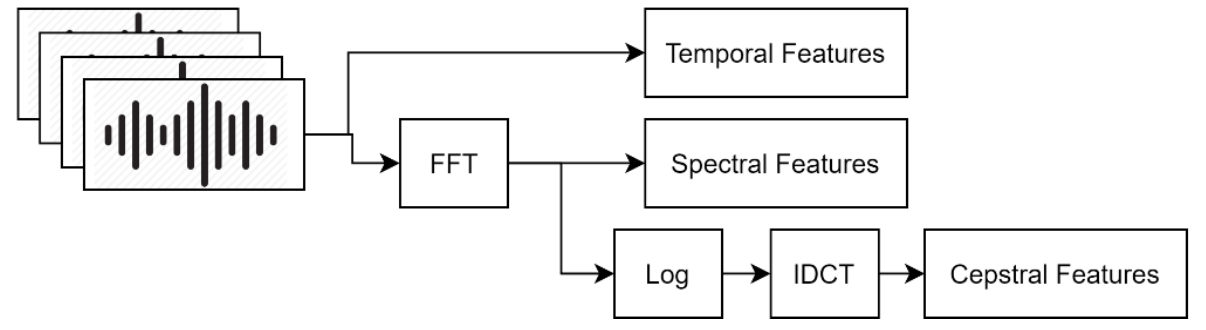
Figure 1. Taxonomy of features extracted from audio.